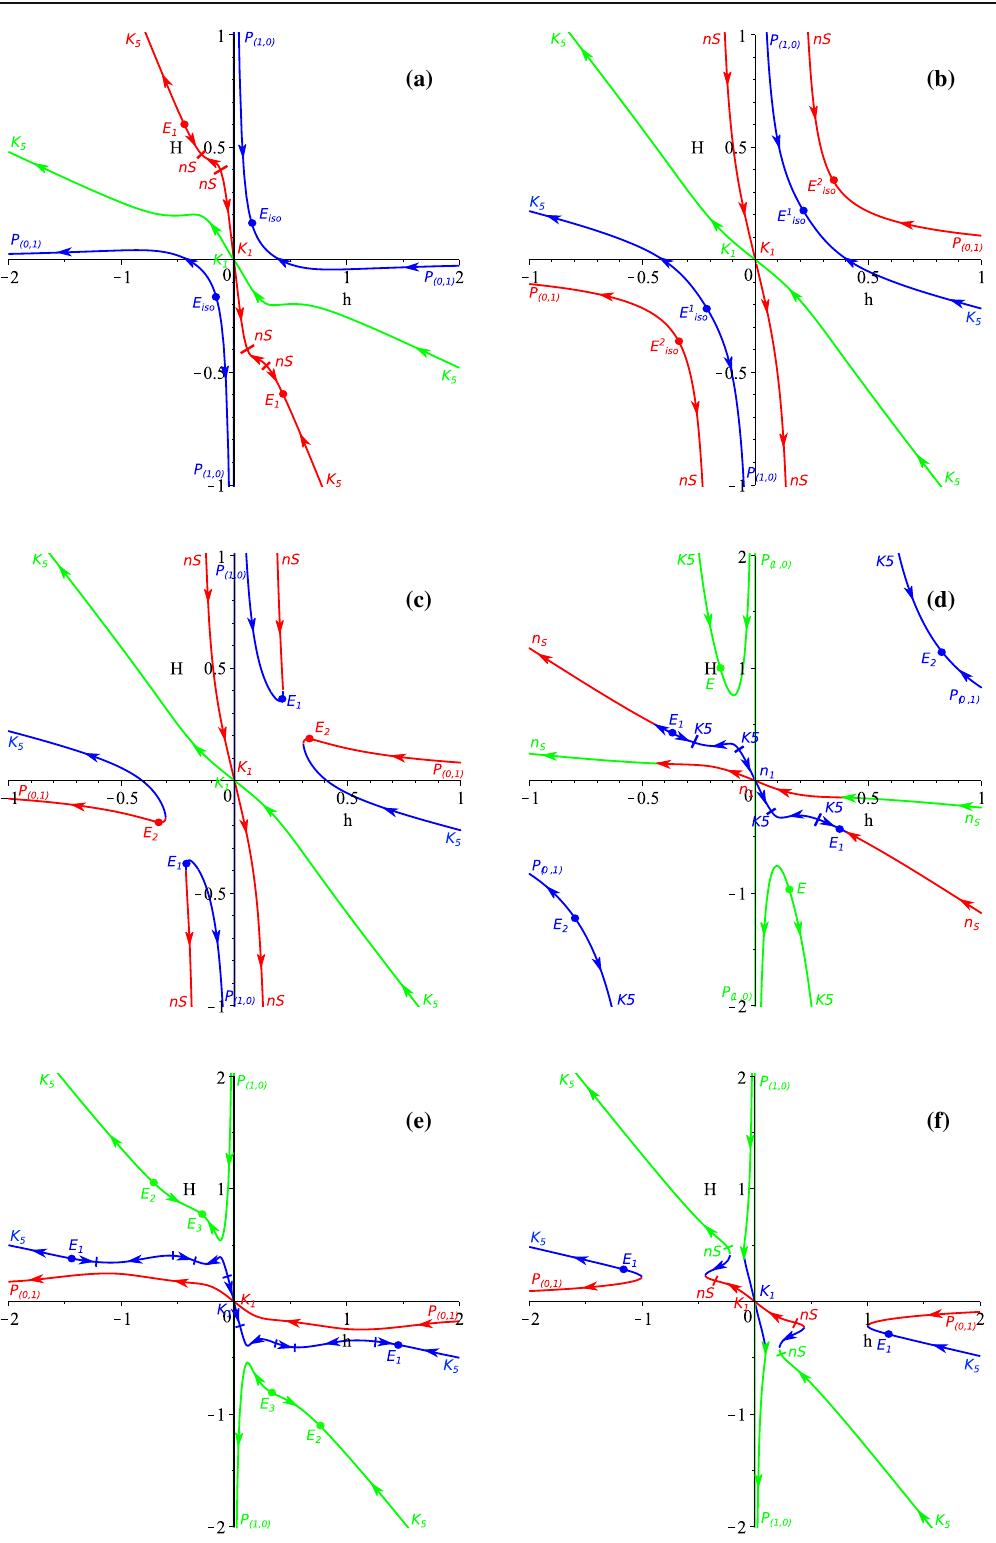
Fig. 1 Final compilations of all possible regimes in D = 5 vacuum cubic Lovelock case, on H ( h ) evolution curves; different colors corre- spond to three different branches H 1 , H 2 and H 3 ; panels layout is